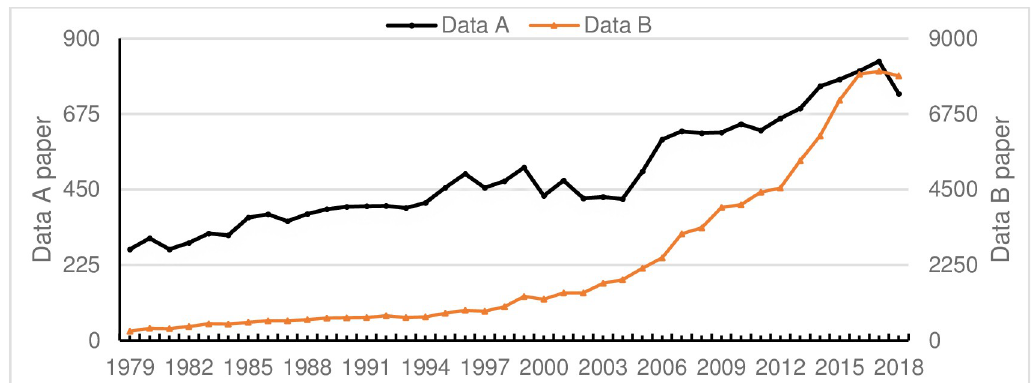
Fig 1. Sets A and B number of documents changes over